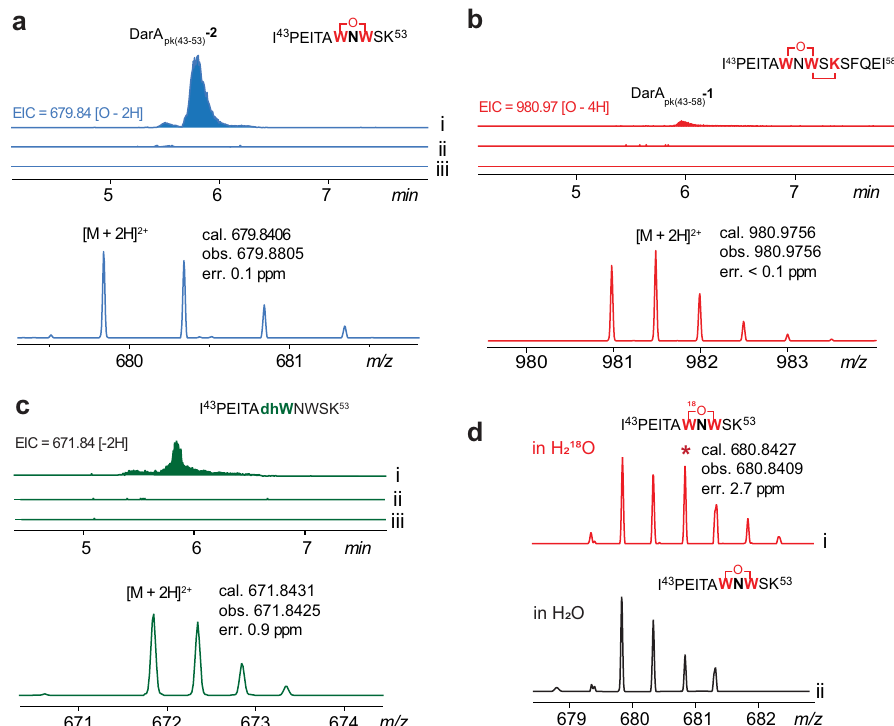
Fig. 3 In vitro analysis of DarE pk . a The EIC and HRMS spectrum corresponding to the tryptic fragment DarA pk(43-53) - 2 , which contains an ether-crosslink between Trp49 and Trp51. b The EIC and HRMS spectrum corresponding to the tryptic fragment DarA pk(43-53) - 1 containing the fully modi fi ed bicyclic scaffold. c The EIC and HRMS spectrum corresponding to the tryptic fragment DarA pk(43-53) - 3 likely containing a dehydrogenated Trp51 (dhW). Trace i, ii, and iii correspond to the full reaction, the solution of reconstituted DarE pk , and the negative control with the supernatant of heat-inactived enzyme. d HRMS spectra of the tryptic fragments DarA pk(43-53) - 2 generated in (i) a buffer containing ~80% H 2 18 O, which was obtained by ultra fi ltration and H 2 18 O dilution. The asterisk indicates 18 O incorporation (~50% enrichment) into the resulting peptide. A control experiment (ii) was performed in parallel with H 2 O. See Supplementary Fig. 12 for the detailed comparison of the HR-MSMS spectra for the 18 O-labeled vs. unlabeled tryptic fragments DarA pk(43 – 53) − 2